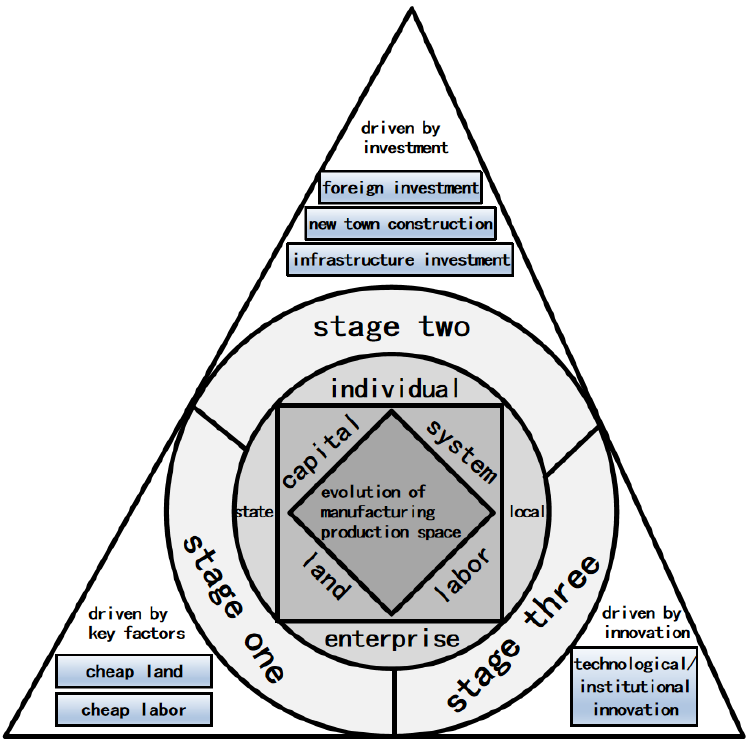
Figure 11. Analysis of the driving mechanism of manufacturing production space evolution.